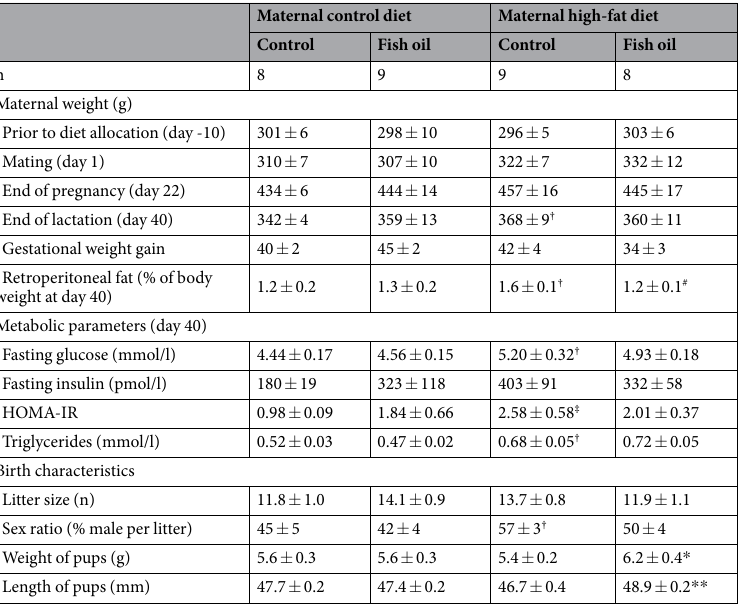
Table 3. Maternal weight and metabolic parameters at key milestones of the study and litter characteristics at birth, according to the maternal diet (control or high-fat) and the gavage treatment during pregnancy [fish oil or control (water)]. Data are means ± standard errors. ‡ p < 0.06 and † p < 0.05 for a maternal diet effect among controls; # p < 0.06, * p < 0.05, and ** p < 0.01 for an effect of the gavage treatment between groups exposed to the same maternal